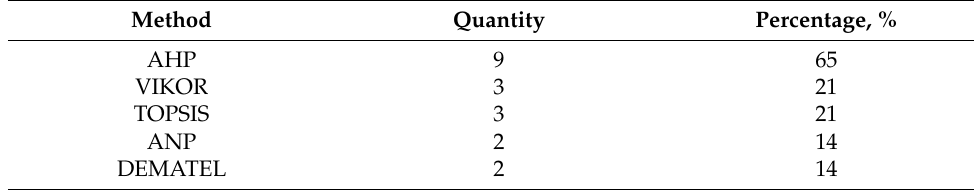
Table 2. Quantity of using methods in presented